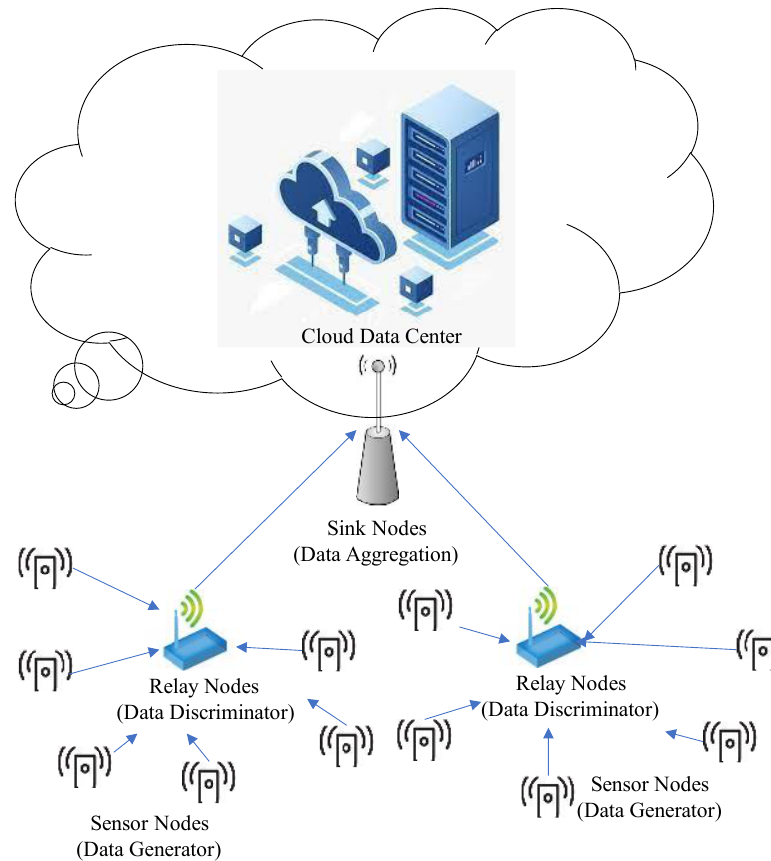
Figure 1. WSN Architecture with Data Aggregation in Different Levels of Sensor Nodes.